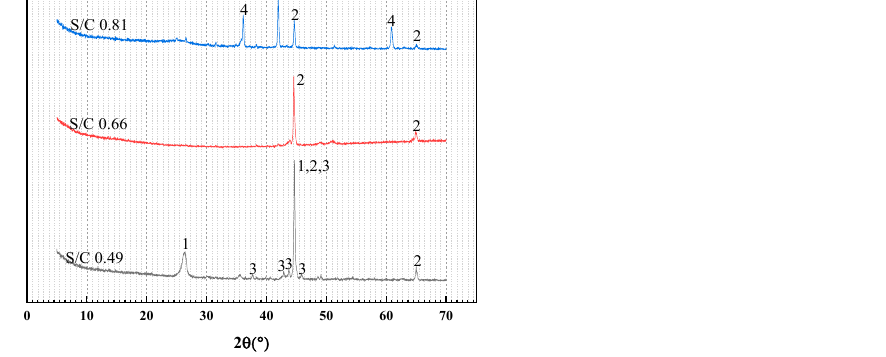
Figure 5. The effect of S/C on the XRD pattern of reduced OC. 1-C; 2-Fe; 3-Fe 3 C; 4-FeO 1 − δ .